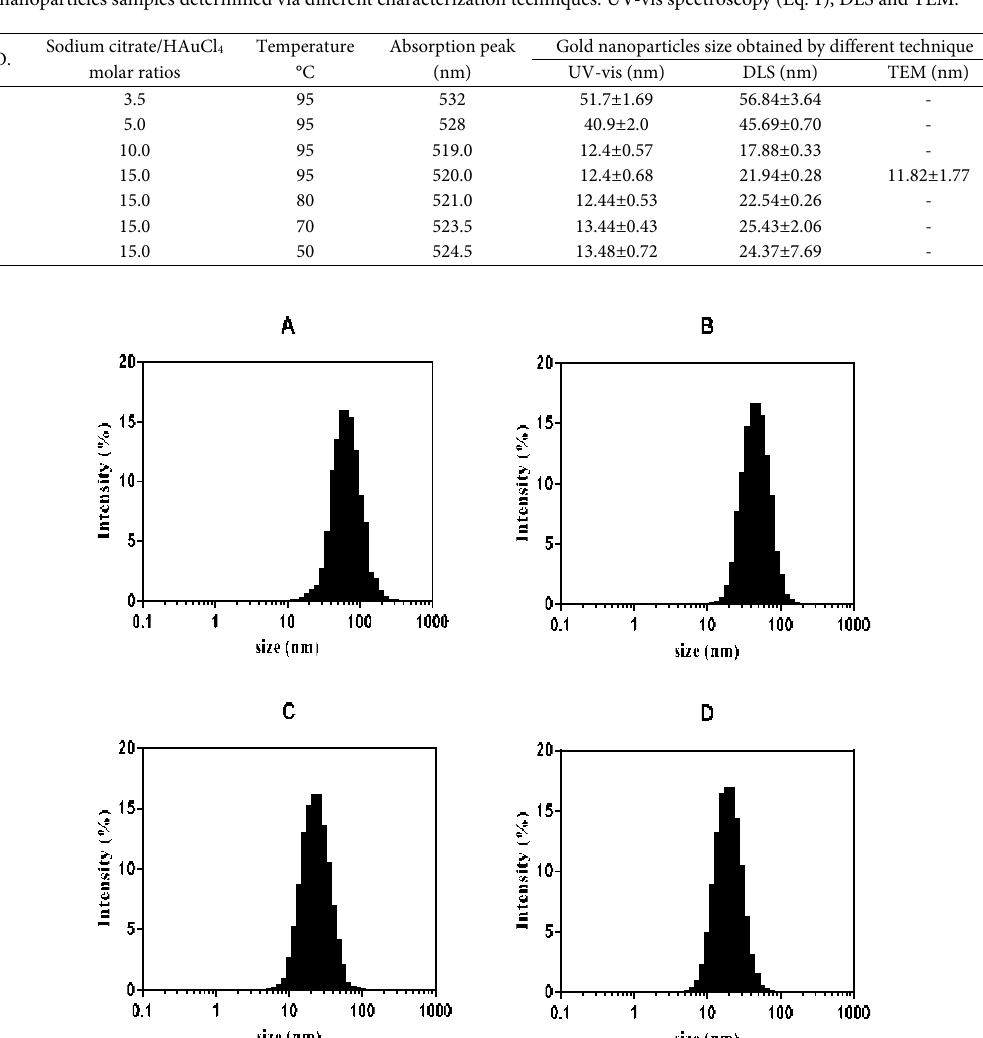
Fig. 2. Size distribution based on light scattering intensity (%) of gold nanoparticles samples that synthesized at different Sodium citrate/HAuCl 4 molar ratios: A) 3.5, B) 5.0, C) 10.0 and D) 15.0.